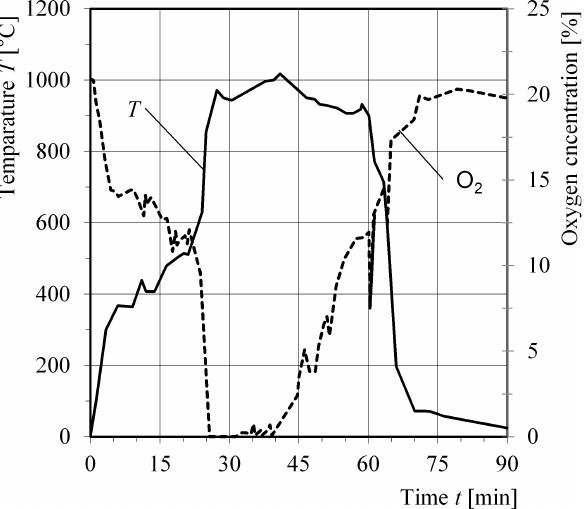
Figure 1: Compartment temperature and oxygen concentration in a compartment fire experiment